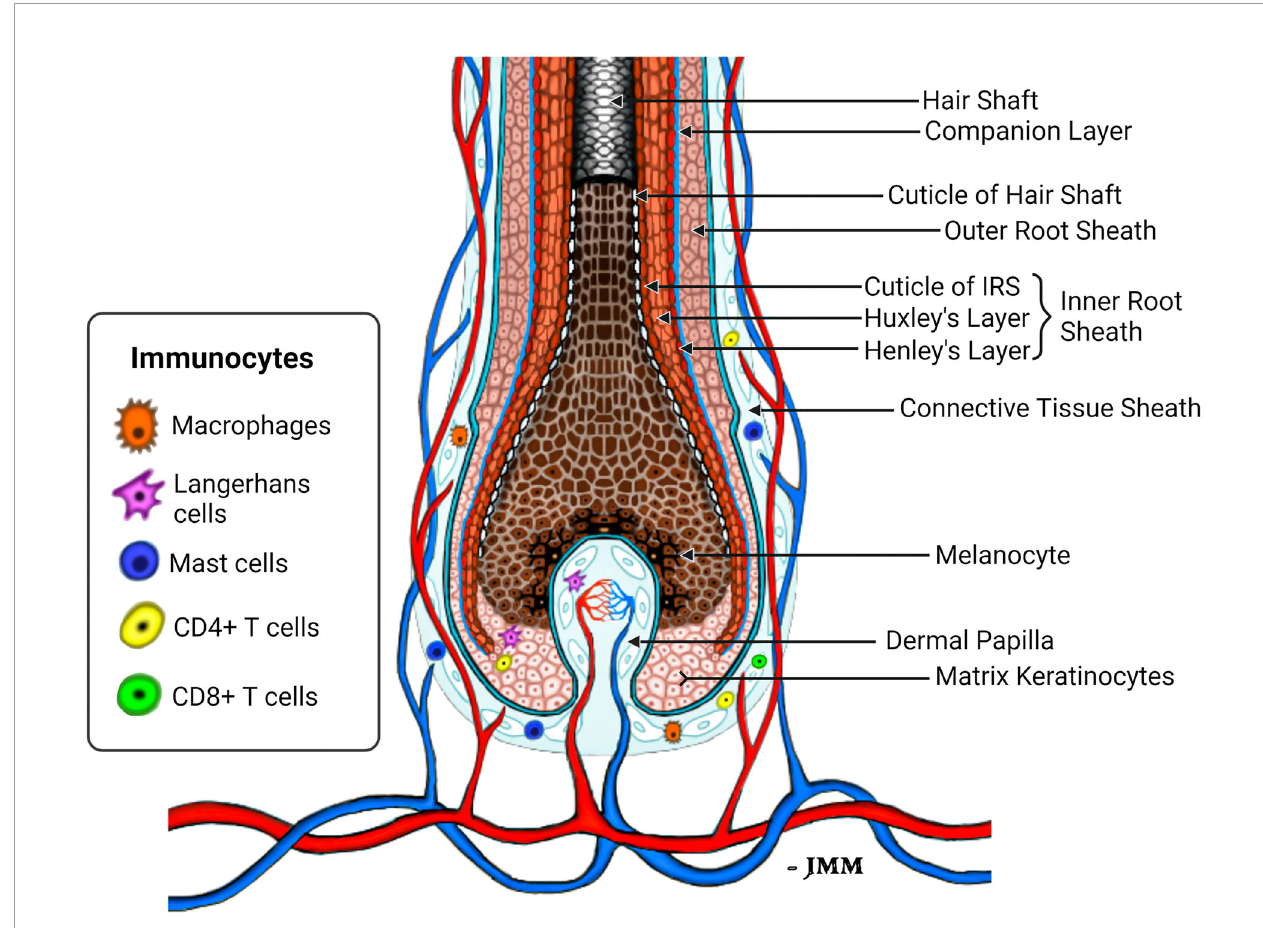
FIGURE 1 | Schema of the healthy lower anagen scalp hair follicle. Different compartments of the HF bulb are shown, including the location of peri-follicular and intra-follicular vasculature and presence of immunocytes that normally reside in the HF connective tissue sheath and hair bulb epithelium